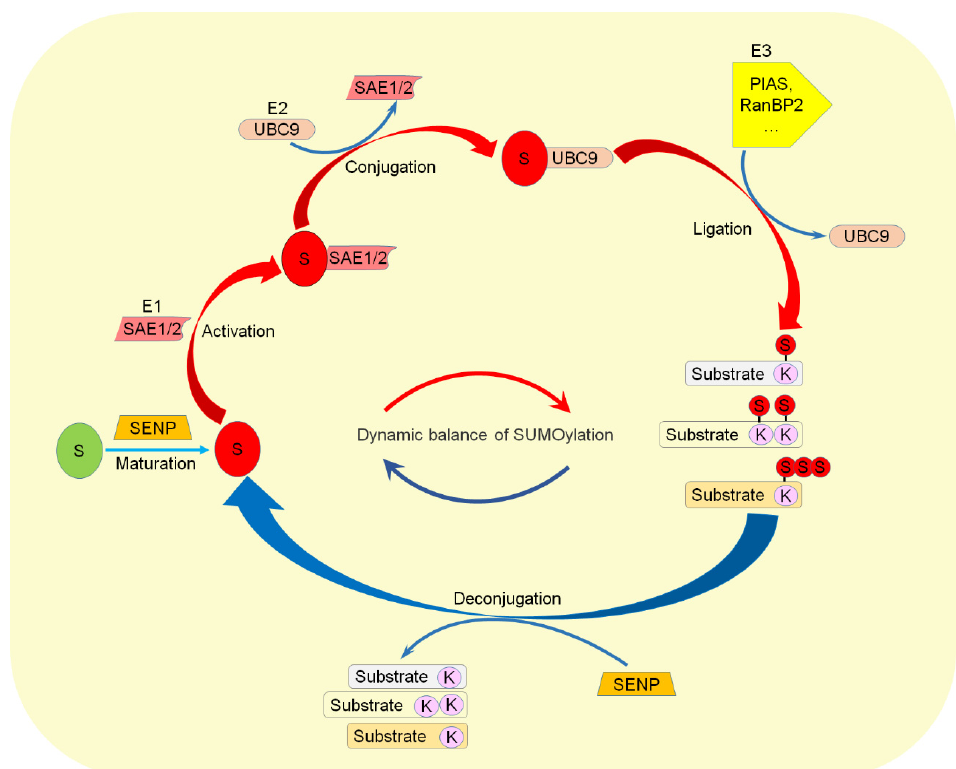
Figure 1. Dynamic regulation of the SUMOylation pathway. The SUMO precursor protein is matured by SENP and then activated by E1, conjugated by E2, and ligated to substrates by E3. On the other hand, SENP deconjugates SUMO from target proteins. S: SUMO. K: Lysine.